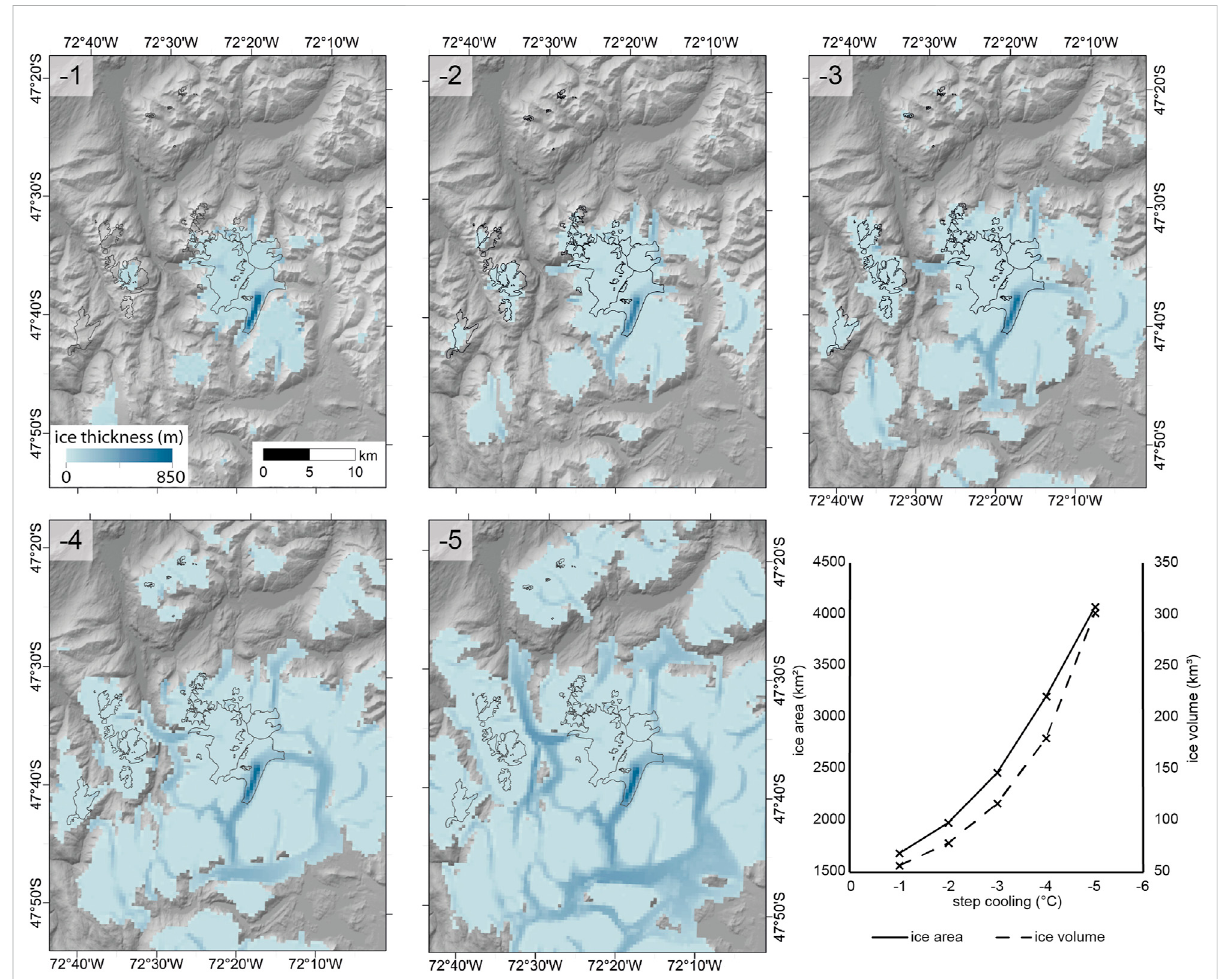
FIGURE 4 Experiment E. Model simulations of the MSL ice cap under surface air temperature step cooling of 1 – 5 ° C and present-day constant precipitation. Present-day ice extent shown as black outline. Graph shows modelled ice area and volume at equilibrium through fi ve simulations under step cooling of − 1 to − 5 °